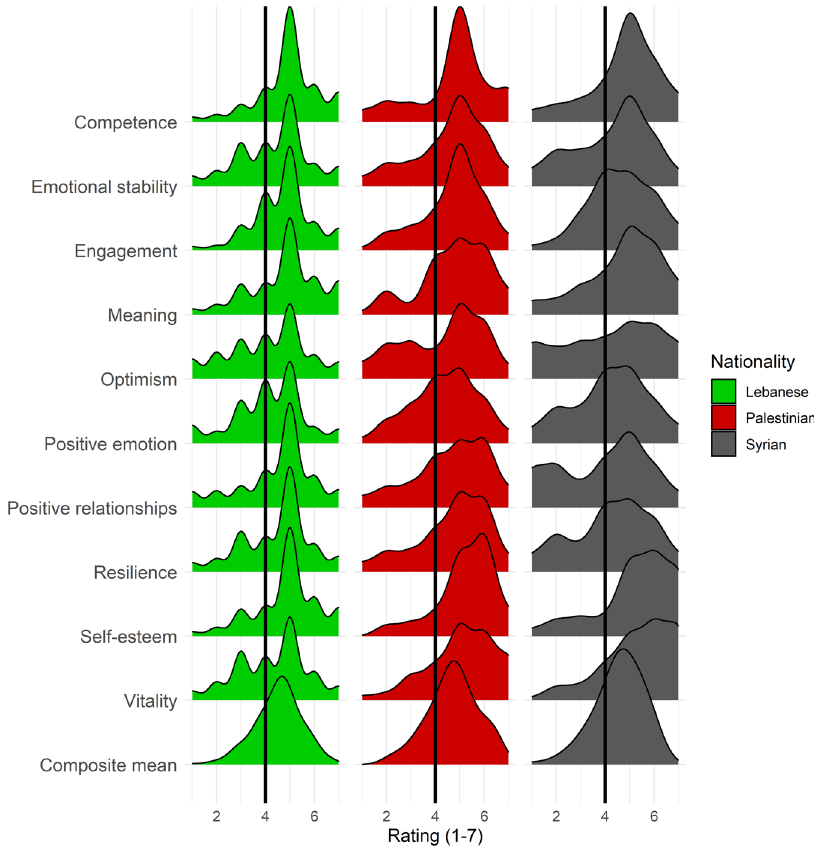
Fig. 2 Distribution of 10 well-being dimensions between Lebanese, Syrians, and Palestinians. Distributions for each individual dimension on the well- being measure, separated into Lebanese citizens, Palestinian refugees, and Syrian refugees. The thick line at 4 represents the scale mid-point for each item. Though distributions between countries, all means lean positive, and within-country variability is relatively stable for all three groups.